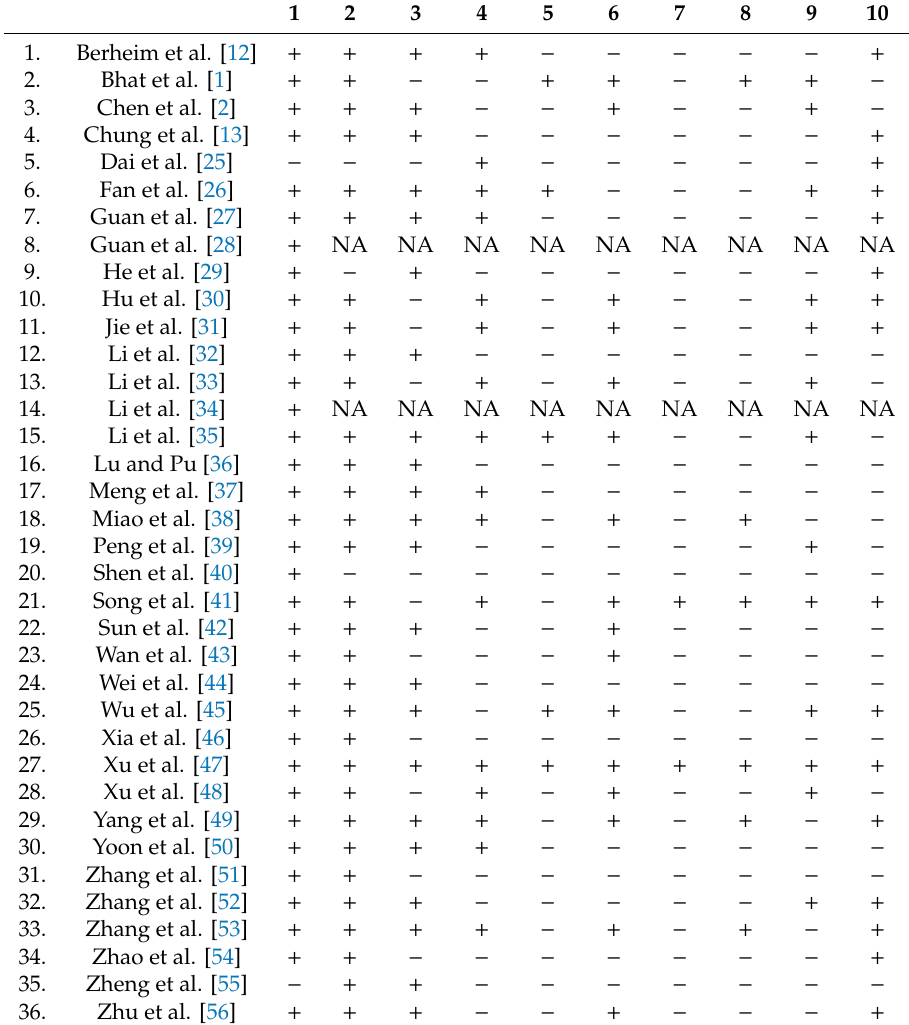
Table 2. Chest computed tomography (CT) morphology abnormality findings of all the eligible